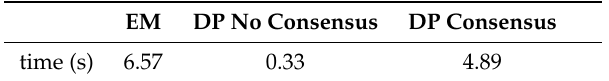
Table 5. Total run times (60 samples).